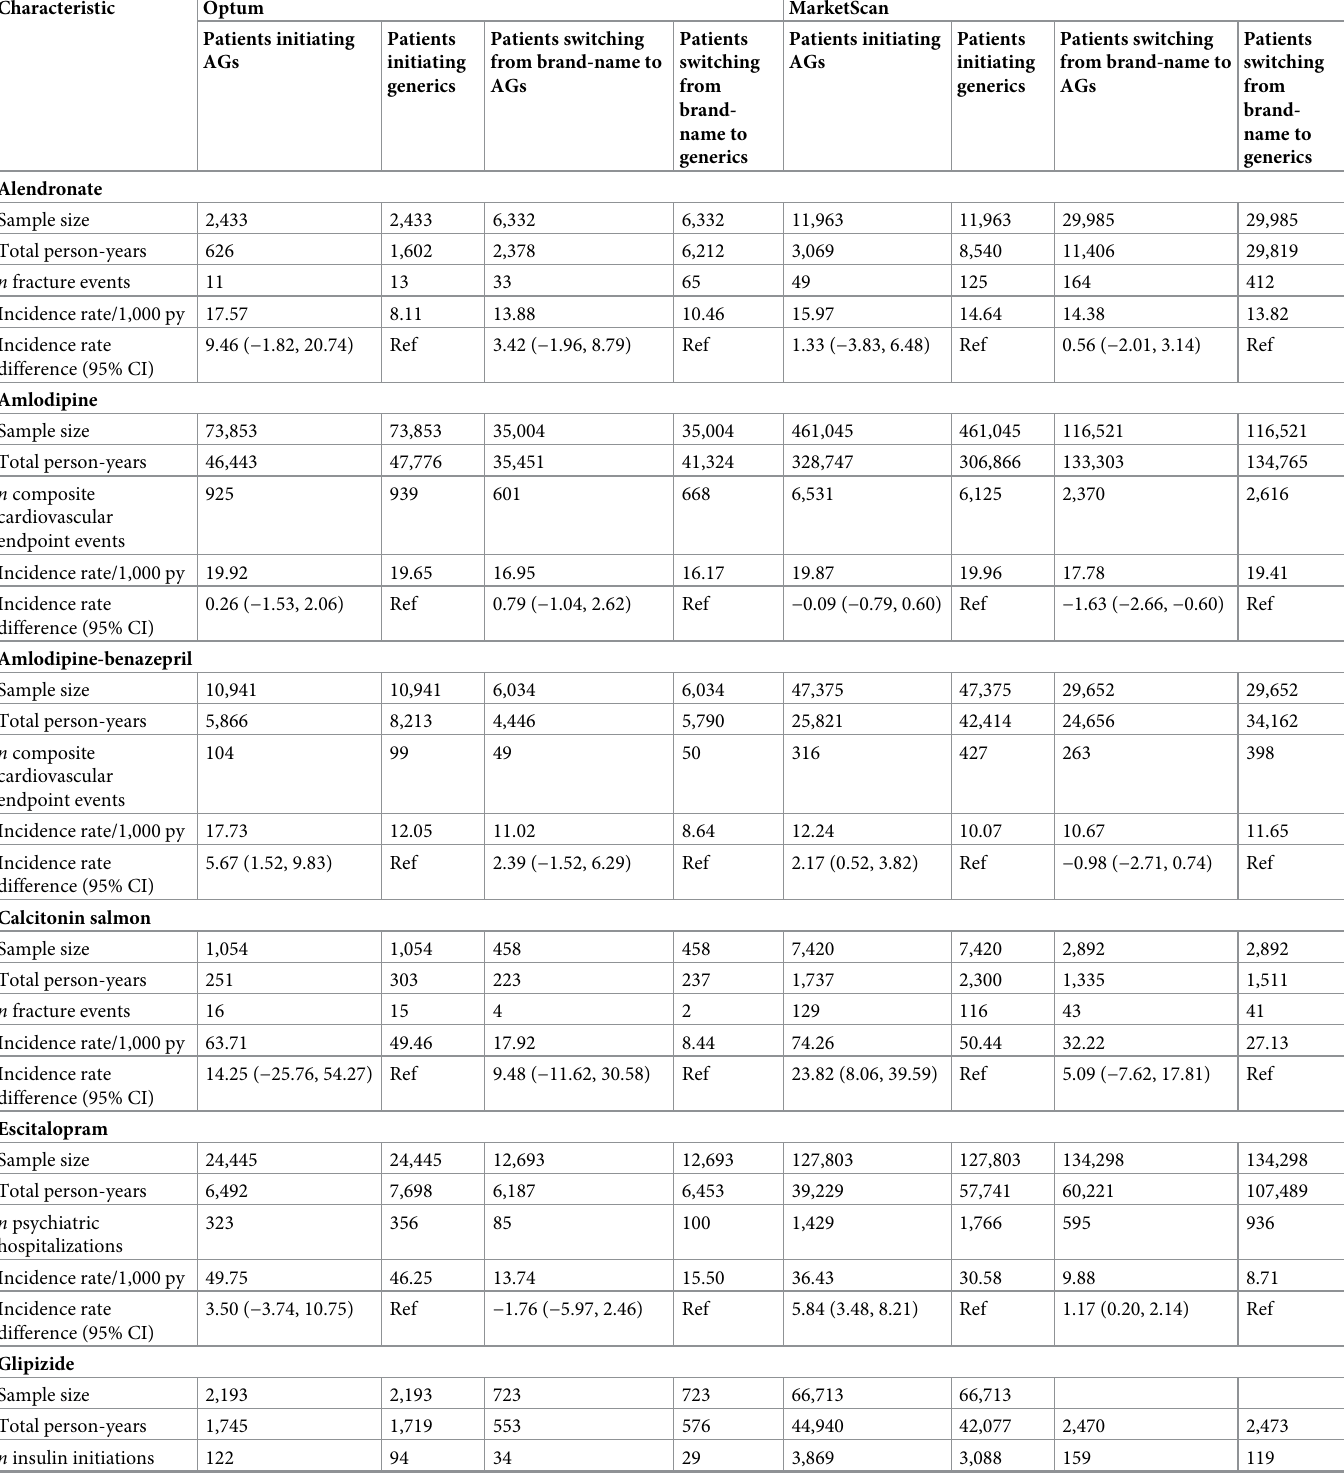
Table 2. Outcome incidence rates for patients initiating authorized generics (AGs) versus generics, and patients switching from brand-name products to AGs ver- sus generics, after 1:1 propensity score matching in each database.